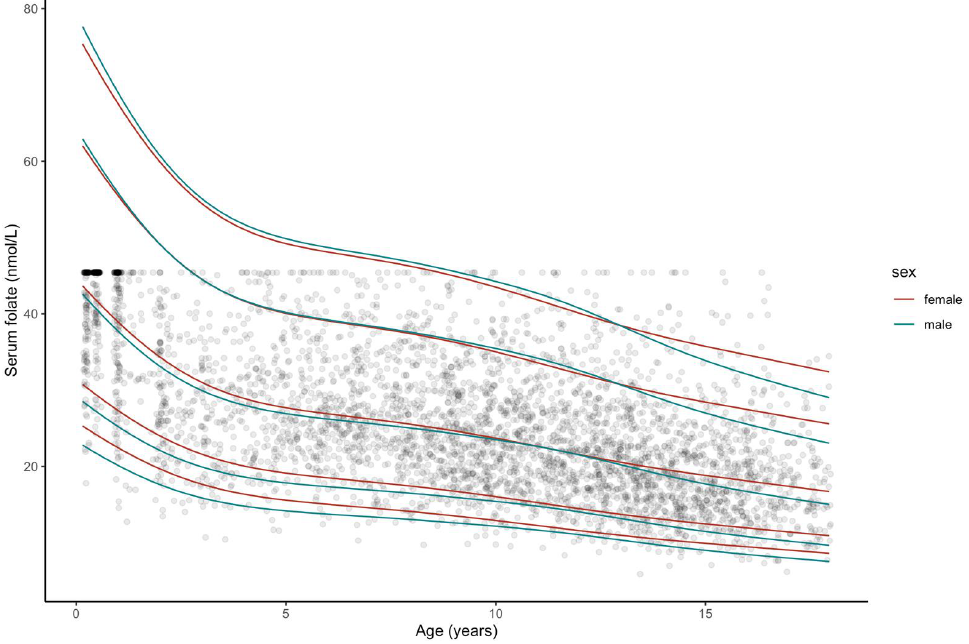
Figure 1. Smoothed percentile curves for serum folate concentrations according to age, based on censored data from a sample of generally healthy participants from the LIFE (Leipzig Research Centre for Civilization Diseases) Child study population. In total, there are 4171 observations from participants aged 2 months–18 years, single data points depicted. From bottom: 2.5th (P2.5),10th (P10), 50th (P50, median), 90th (P90), 97,5th (P97.5) percentiles are marked. Smoothed percentiles produced with Cole’s LMS-type method.